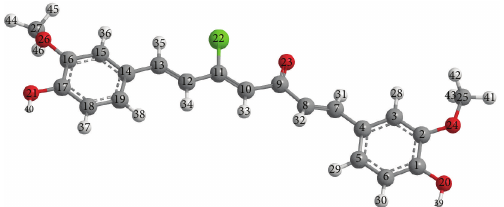
Figure 2: Optimised 3D geometrical structure for 5-chlorocur-